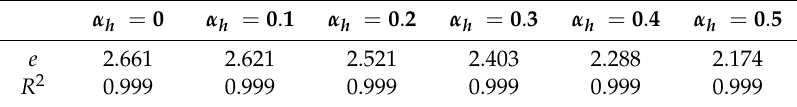
Table 2. Fitting parameters of Type A cell analyses.